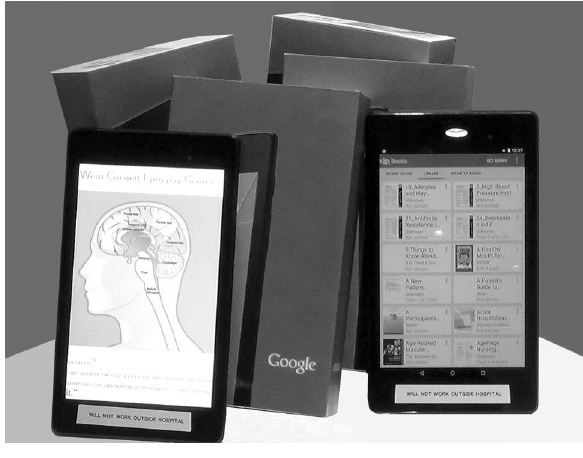
Nexus 7 tablets with clinical-domain-specific